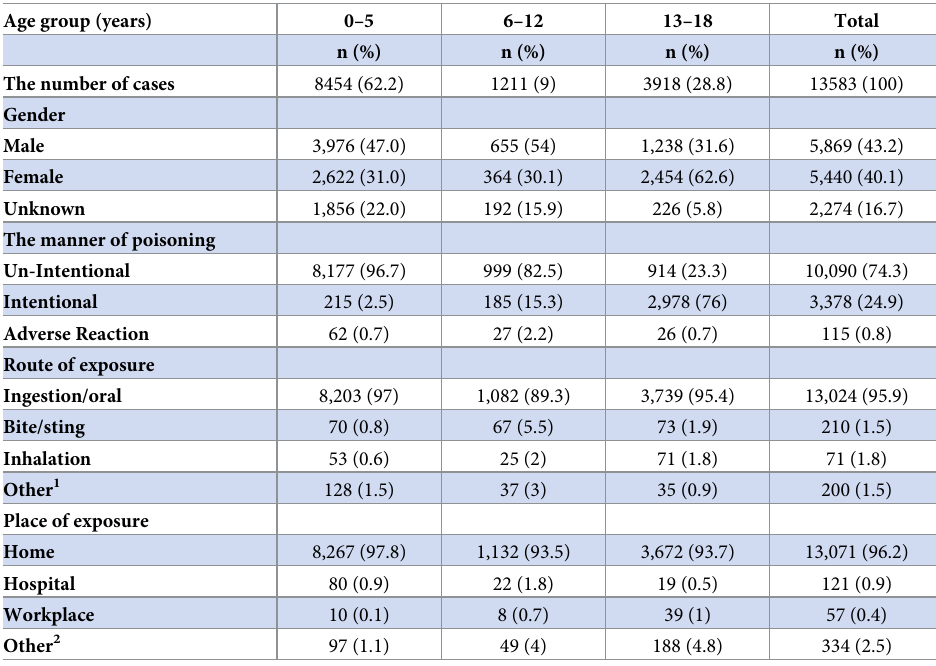
Table 1. The characteristics of poisoning according to the age groups of the